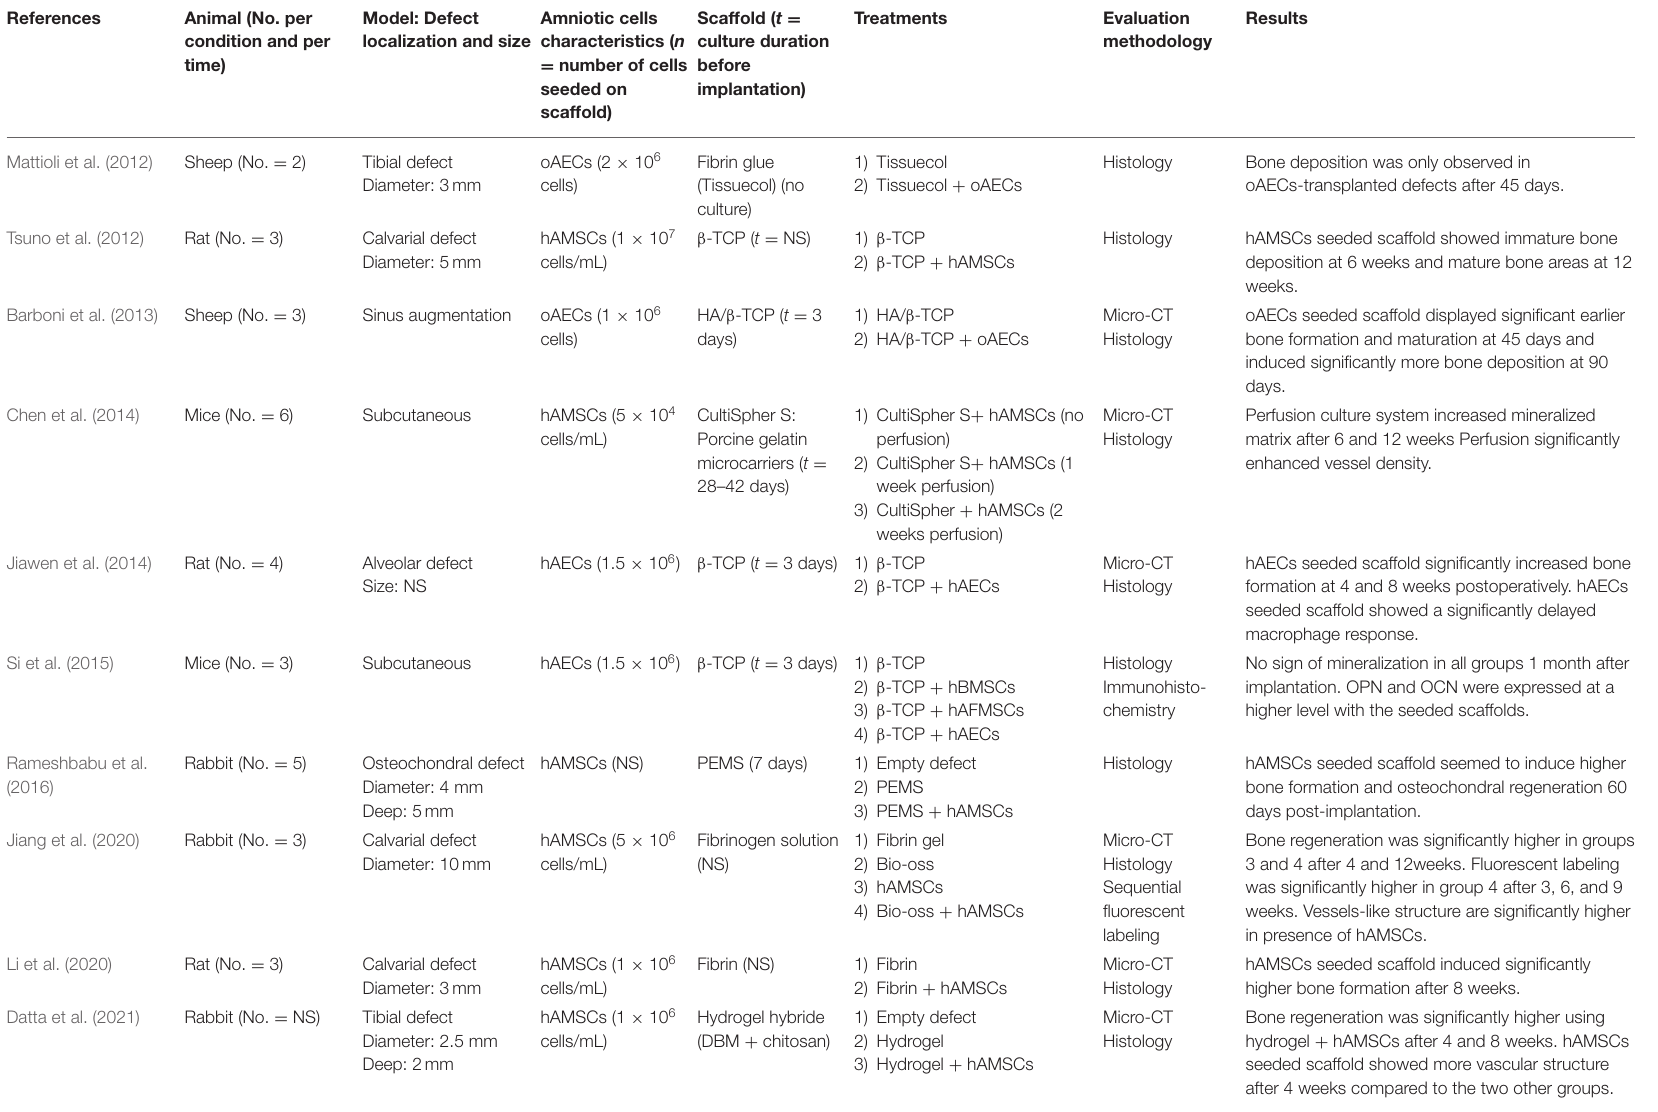
TABLE 5 | Pre-clinical studies using amniotic membrane derivated stromal cells for bone